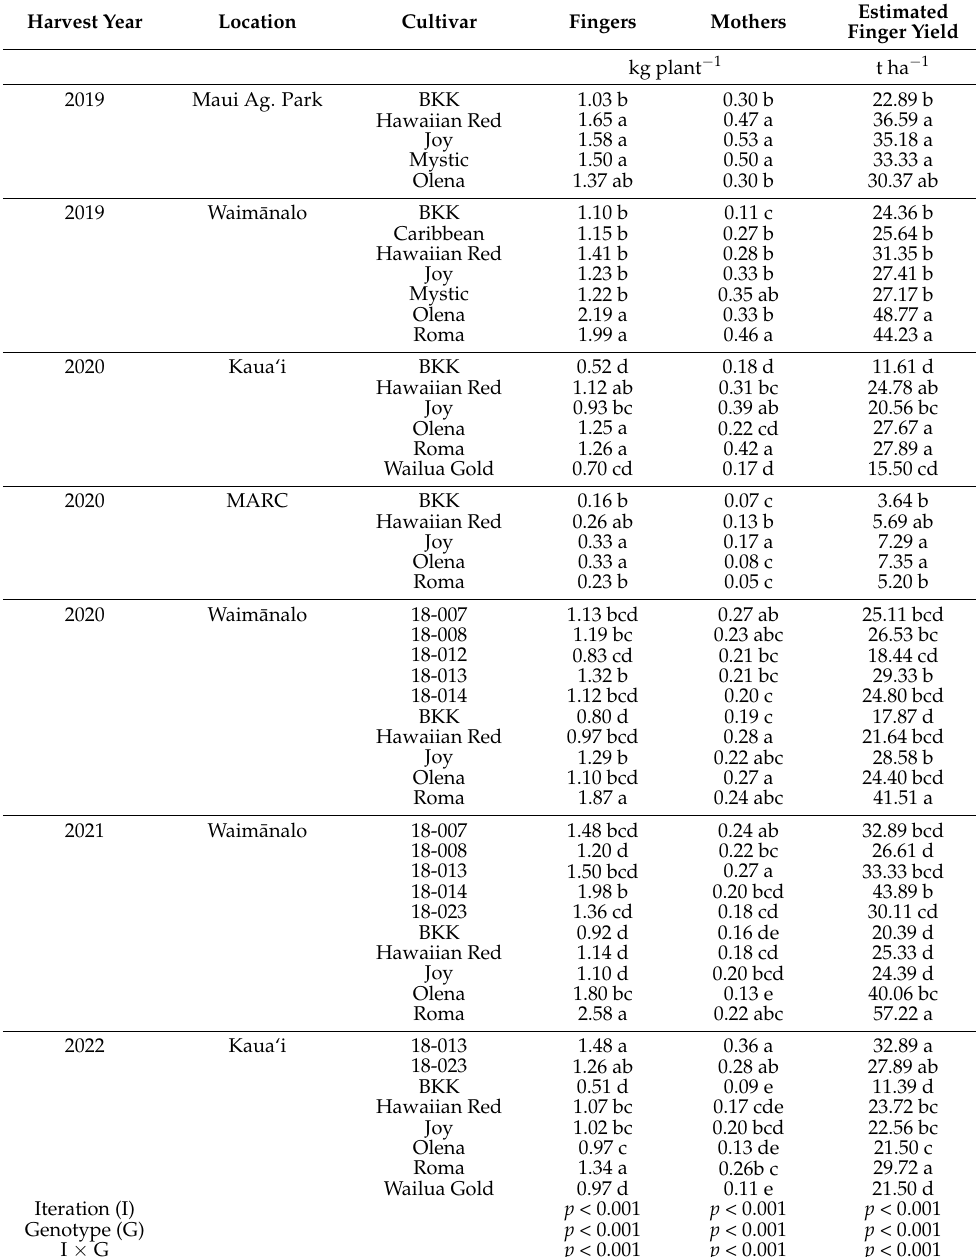
Table 1. Rhizome (finger) and corm (mother) weight of turmeric cultivars grown at four locations over 4 years in Hawai’i. Letters within columns of each year/location combination indicate Fisher protected LSD means separation, where means having the same letter are not significantly different from each other. Estimated yield is based on a plant population of 22,222 plant per hectare based on spacing of 30 cm within rows and 150 cm between rows, including access